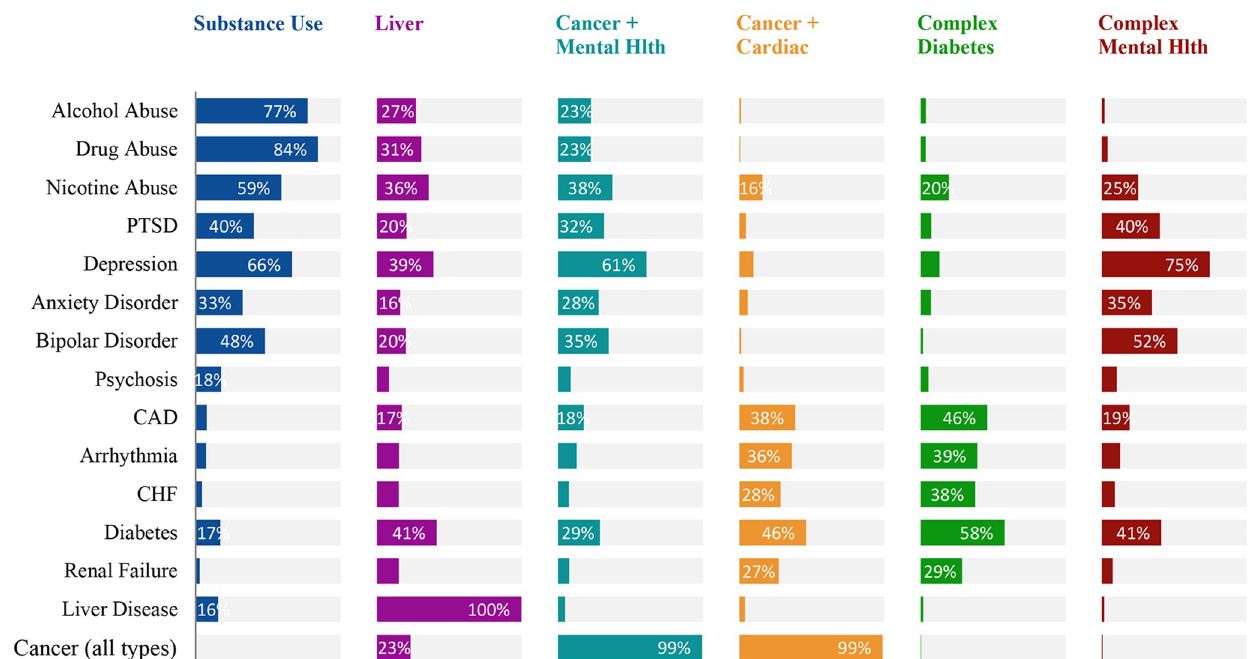
Fig 2. Prevalence of medical conditions by subgroup (prevalence rates < 15% not labeled). This bar chart shows the prevalence of selected medical condition used to help label the subgroups. Not all of these medical conditions were included in the final models because they either were too prevalent ( > 95%) or not prevalent enough ( < 5%), but were presented here descriptively to help identify the nature of the